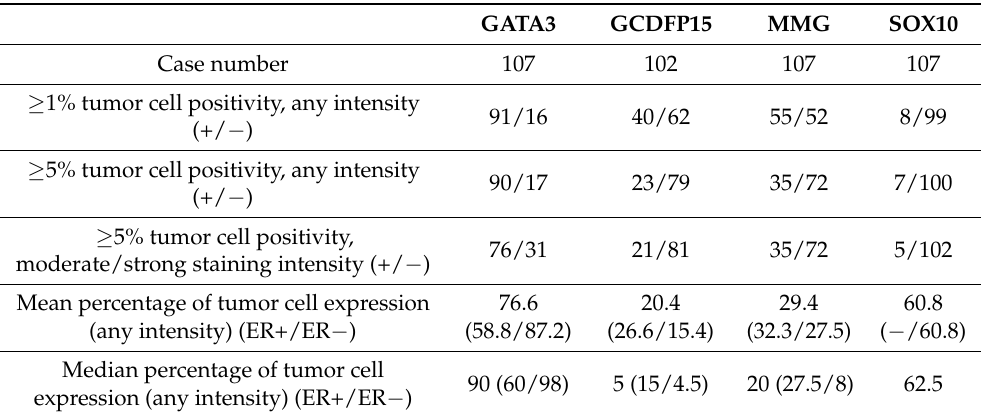
Table 2. The expression of GATA3, gross cystic disease fluid protein-15 (GCDFP15), mammaglobin (MMG) and SOX10 in aspirates of metastatic breast